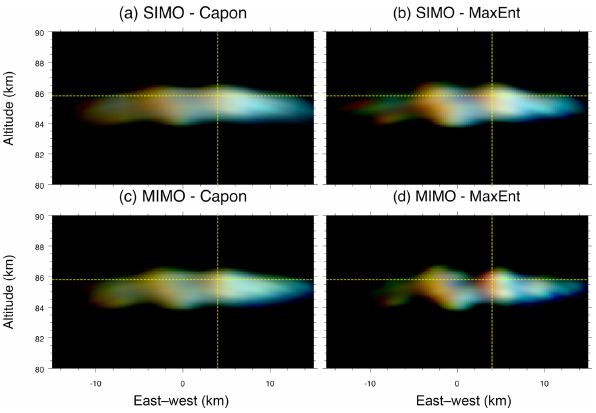
Figure 4. Similar to Fig. 3, but for an EW–altitude cut at y = 0km. The yellow dashed horizontal lines represent the location of the al- titude cuts shown in previous and later figures for Event